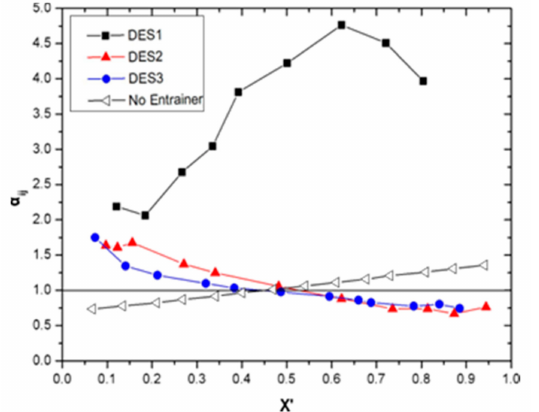
Figure 8. The X 1 - α diagram of cyclohexane(1)-benzene(2)-DES(3) system at 101.3